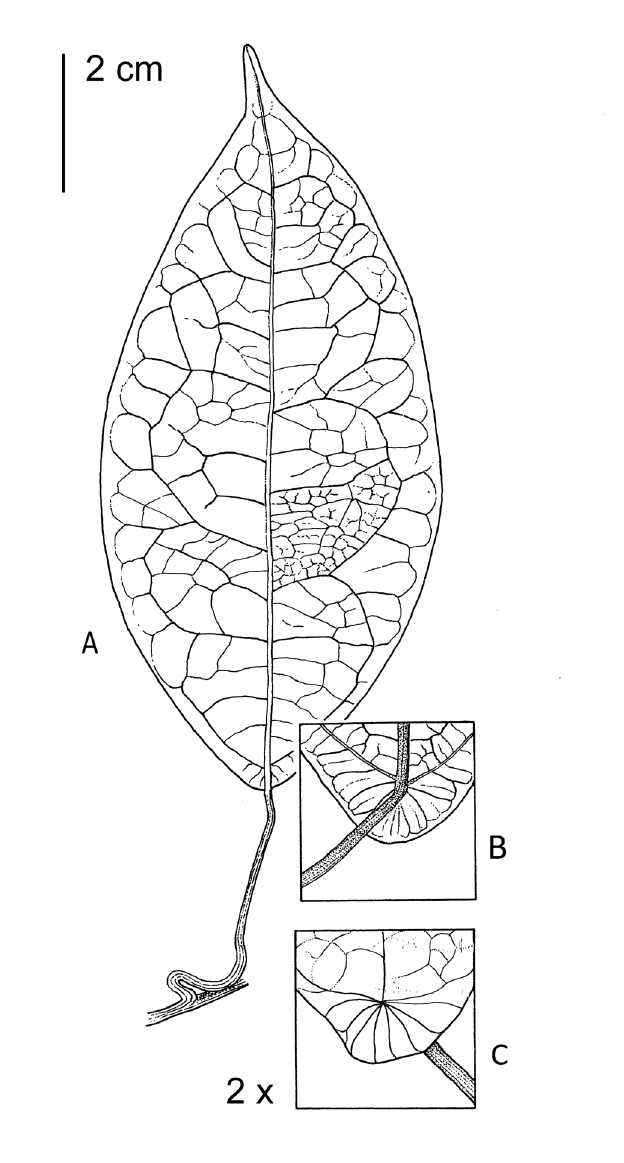
Figure 13 – Rhigiocarya peltata . A . Leaf. B . Leaf base from beneath. C . Leaf base from above. Drawn by Marjolein